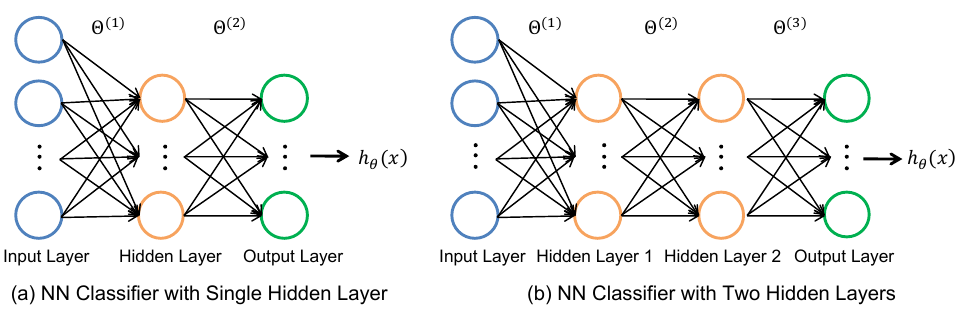
Figure 7. Neural network (NN) classifier architectures used in the design space explorations.